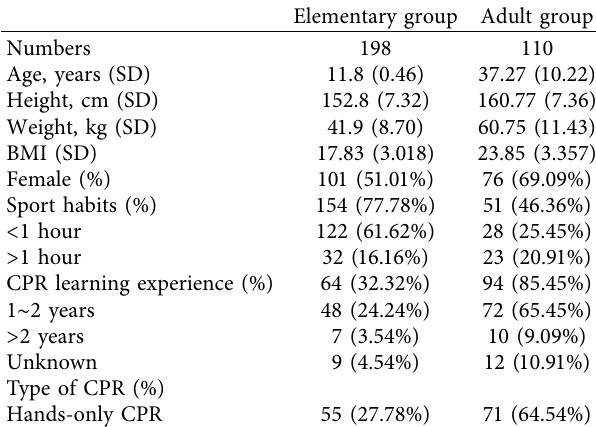
Table 1: Demographic population.